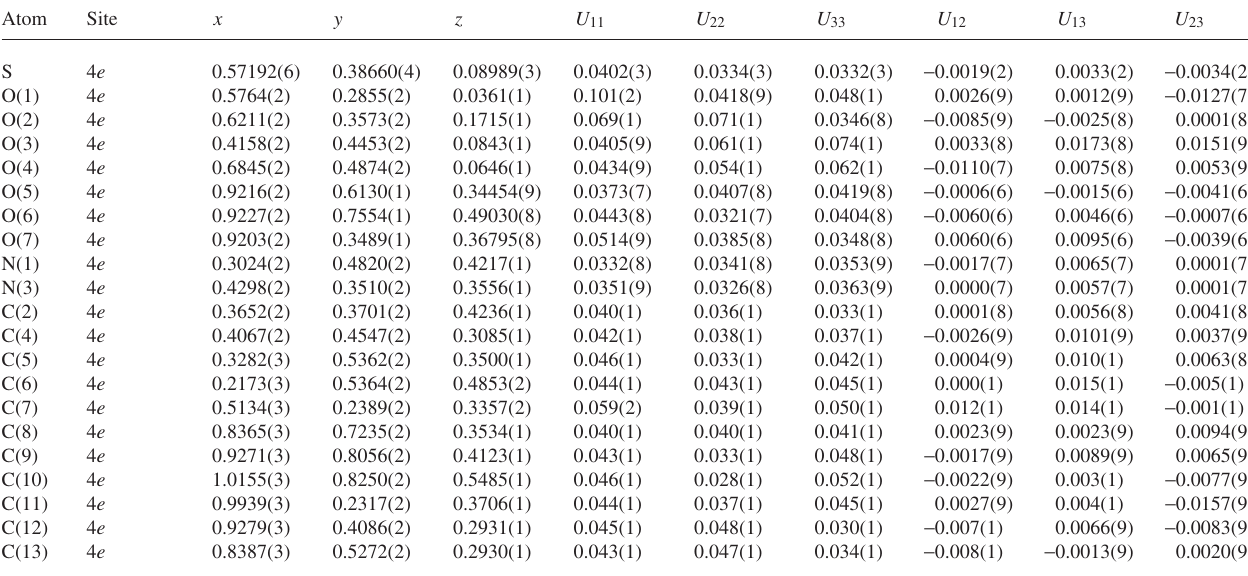
Table 3. Atomic coordinates and displacement parameters (in Å 2 )